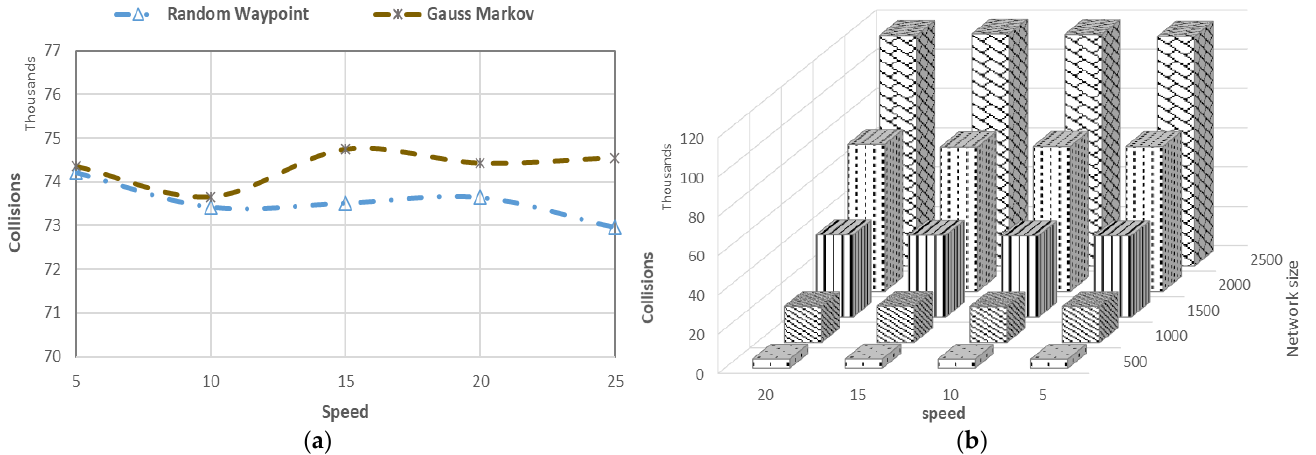
Figure 6. Traffic collisions: ( a ) collisions for a network with 1000 × 1000 area, 2000 devices, and 60 B payload across different speeds in m/s; ( b ) collisions for a network with 1000 × 1000 area using the Gauss – Markov mobility model across different speeds in m/s.